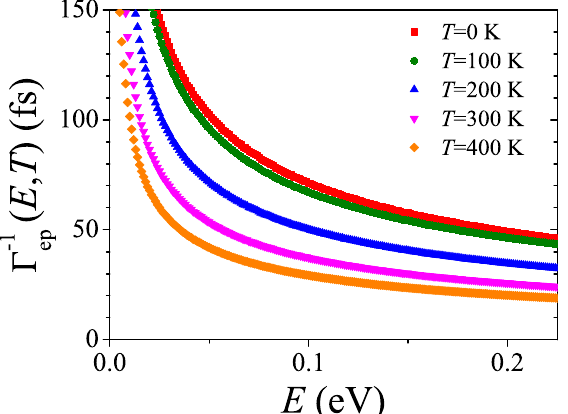
Figure 10. The time constant by the elastic e-ph scattering is given. The energy is referenced from that of the L valley bottom. T represents the phonon temperature, and thus, T = T p . Adapted with